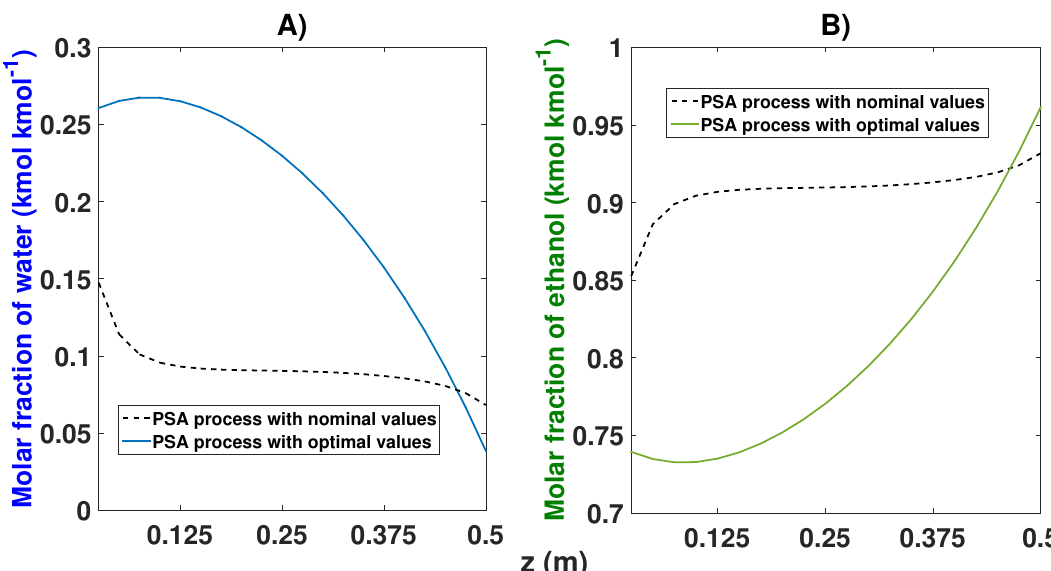
Figure 23. Comparison of water–ethanol adsorption of the optimal model proposed based on the axial coordinate. ( A ) Effects of nominal and optimal values on the molar fraction of water; ( B ) Effects of nominal and optimal values on the molar fraction of